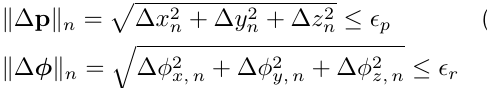
Figure 6: Slide unit configuration of the 3-DOF SPM.